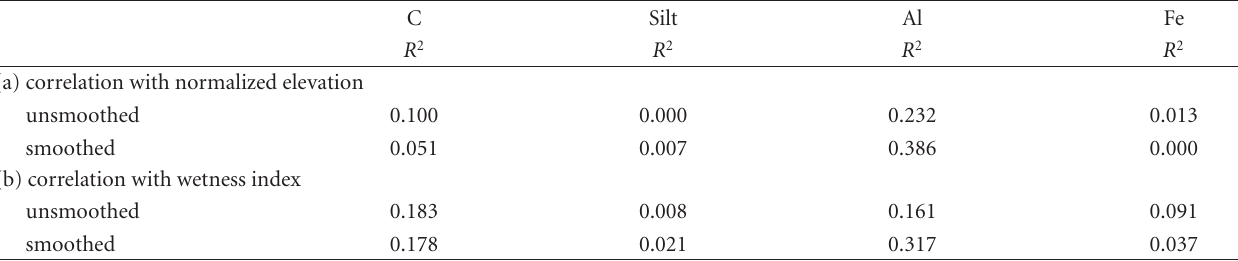
Table 5: Correlation between predicted analyte concentrations and topographic indices including (a) relative elevation data derived from 3m LIDAR DEM, and (b) wetness index calculated from 3m LIDAR DEM, for one of the six sampled fields (Mason). Predicted values were calculated for unsmoothed imagery (2.5m pixel size) and for smoothed imagery to which a 3 × 3 low band filter had been applied. See Section 2 for analyte descriptions.